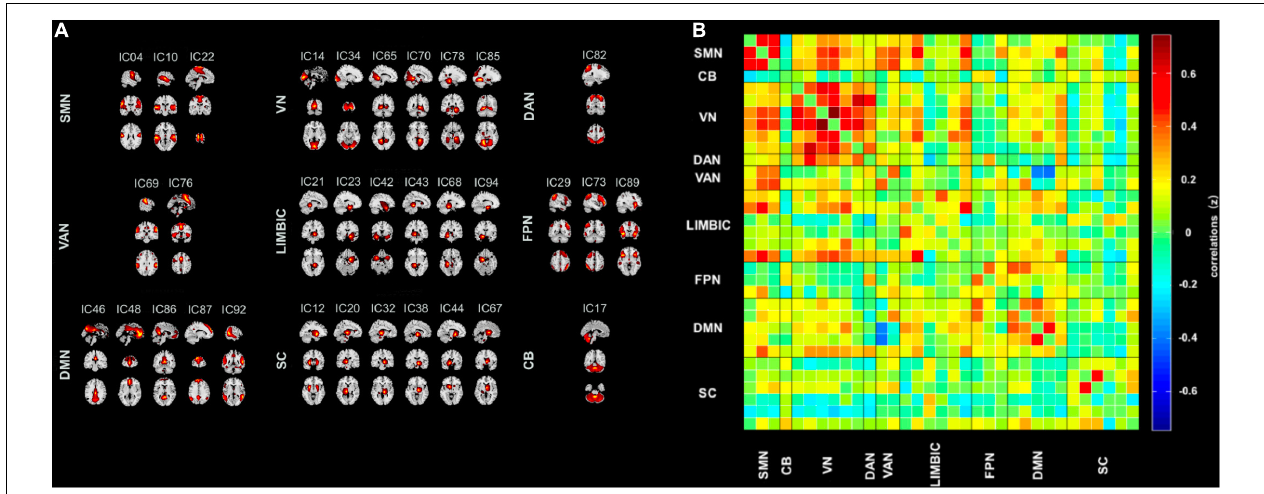
FIGURE 1 | Spatial maps of the 33 intrinsic connectivity networks and the stationary functional connectivity. (A) Independent component networks spatial maps divided into nine functional networks: cerebellum (CB, one component), dorsal attention network (DAN, one component), default mode network (DMN, five components), frontoparietal network (FPN, three components), limbic (LIM, six components), subcutaneous (SC, six components), sensorimotor network (SMN, three components), ventral attention network (VAN, two components), and visual network (VN, six components), based on their anatomical and functional properties. (B) Group averaged static functional network connectivity between independent component pairs computed by the rest state functional MRI data. Connectivity values in the correlation matrix represents the Fisher’s z-transformed Pearson correlation coefficient, averaged over all subjects. IC, independent